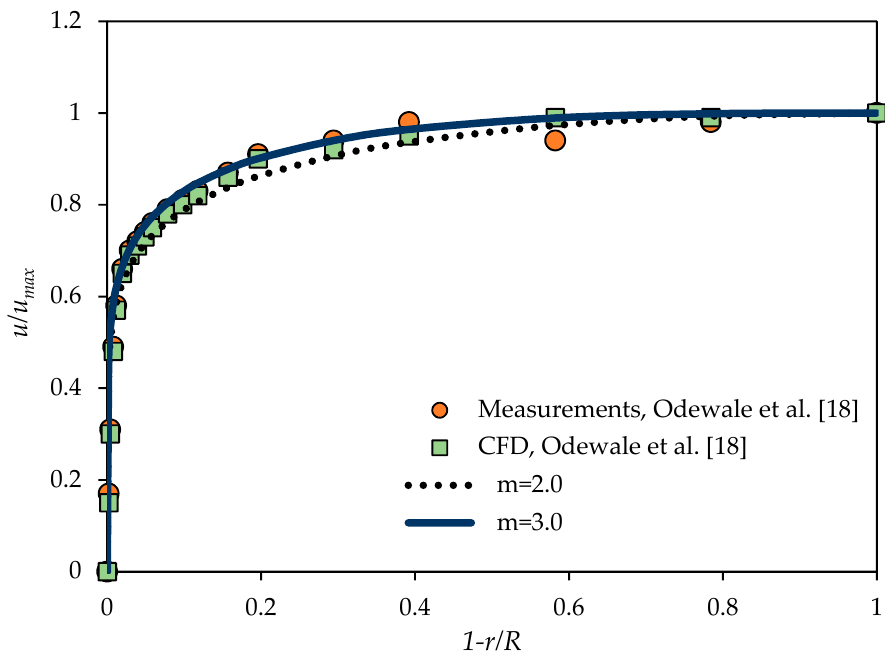
Figure 10. Comparisons between measured and calculated normalized velocity profiles when m takes the values of 1, 2, 3, and 4 and n takes the value of 7.